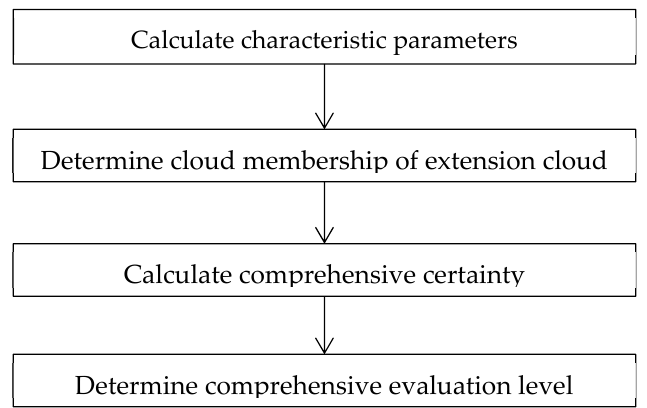
Figure 3. Calculation process of the extension cloud model.